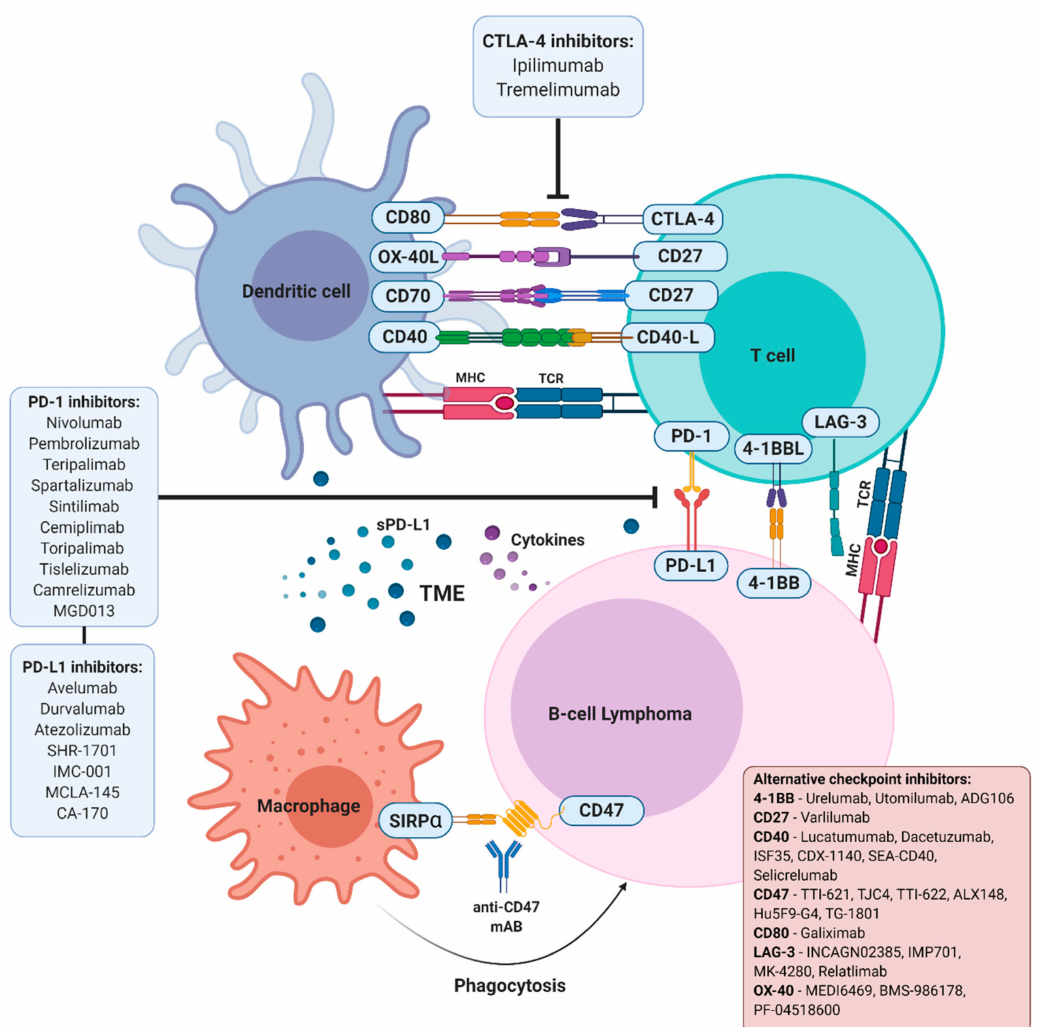
Figure 1. Therapeutic approaches based on immune checkpoint blockade in B-cell lymphomas. Different therapeutic strategies to block PD-1/PD-L1 interaction are under clinical development in order to prevent PD-1-mediated attenuation of TCR signalling, allowing for activity restoration of exhausted CD8+ T-cells. CTLA-4 inhibition by monoclonal antibodies may induce tumour rejection through direct blockade of CTLA-4 competition for CD-80 (B7-1) and CD-86 (B7-2) ligands, which enhances CD28 costimulation and, thus, activation. Alternative immune checkpoint molecules expressed on tumour cells or immune cells in the TME can be simultaneously modulated to restore an effective antilymphoma immune